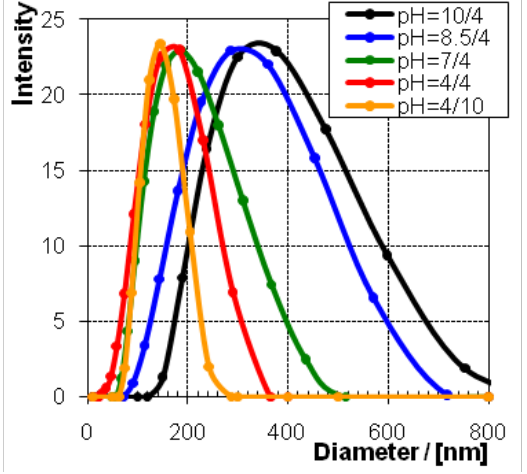
/n = 1.5, c = 0.005 − + PEL